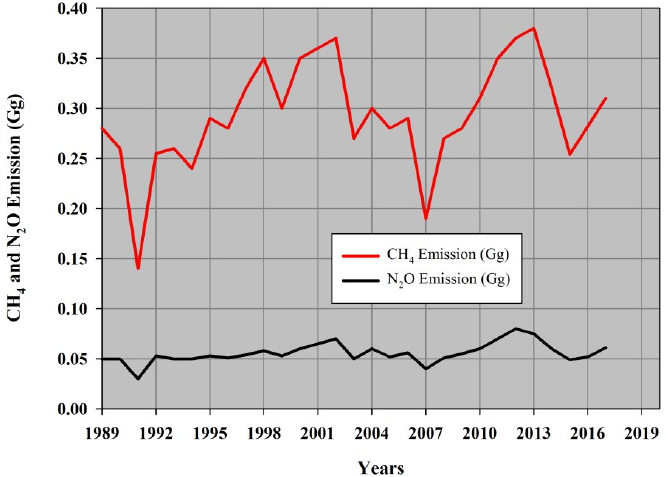
Figure 10. CH 4 and N 2 O emissions from the oil refining industry in Iraq from 1989 to 2017.